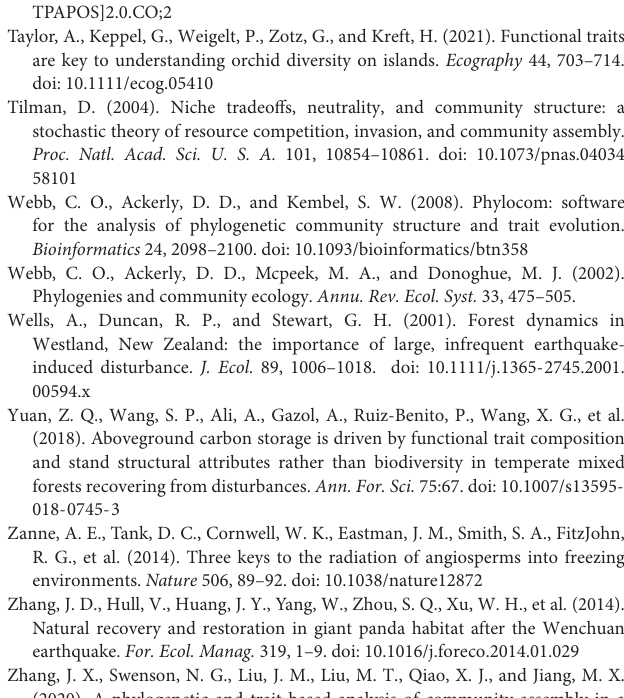
(2020). A phylogenetic and trait-based analysis of community assembly in a